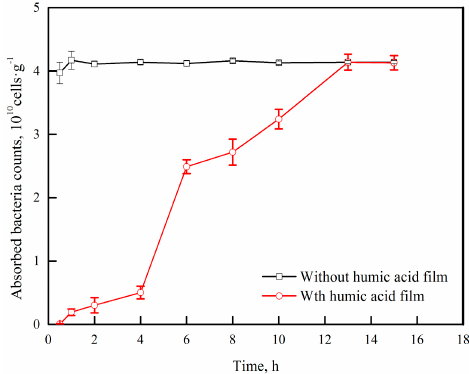
Figure 4. Trend in adsorption of bacteria on pyrite with time.